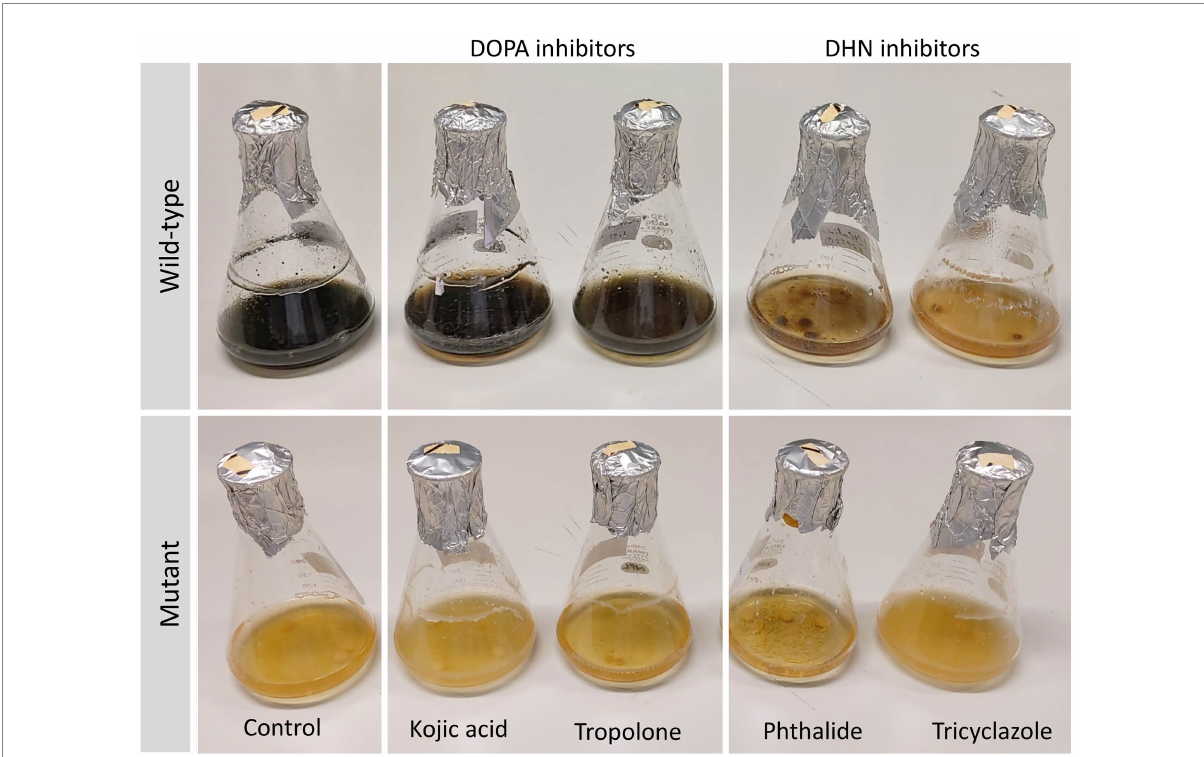
FIGURE 4 Growth of Lophiotrema sp. F6932 wild-type strain and CRISPR/Cas9-induced mutants in PDB in the presence of different melanin synthesis inhibitors after 6 days. The concentration of kojic acid, phthalide, and tricyclazole used was 100 μ g/mL while 12.5 μ g/mL of tropolone was